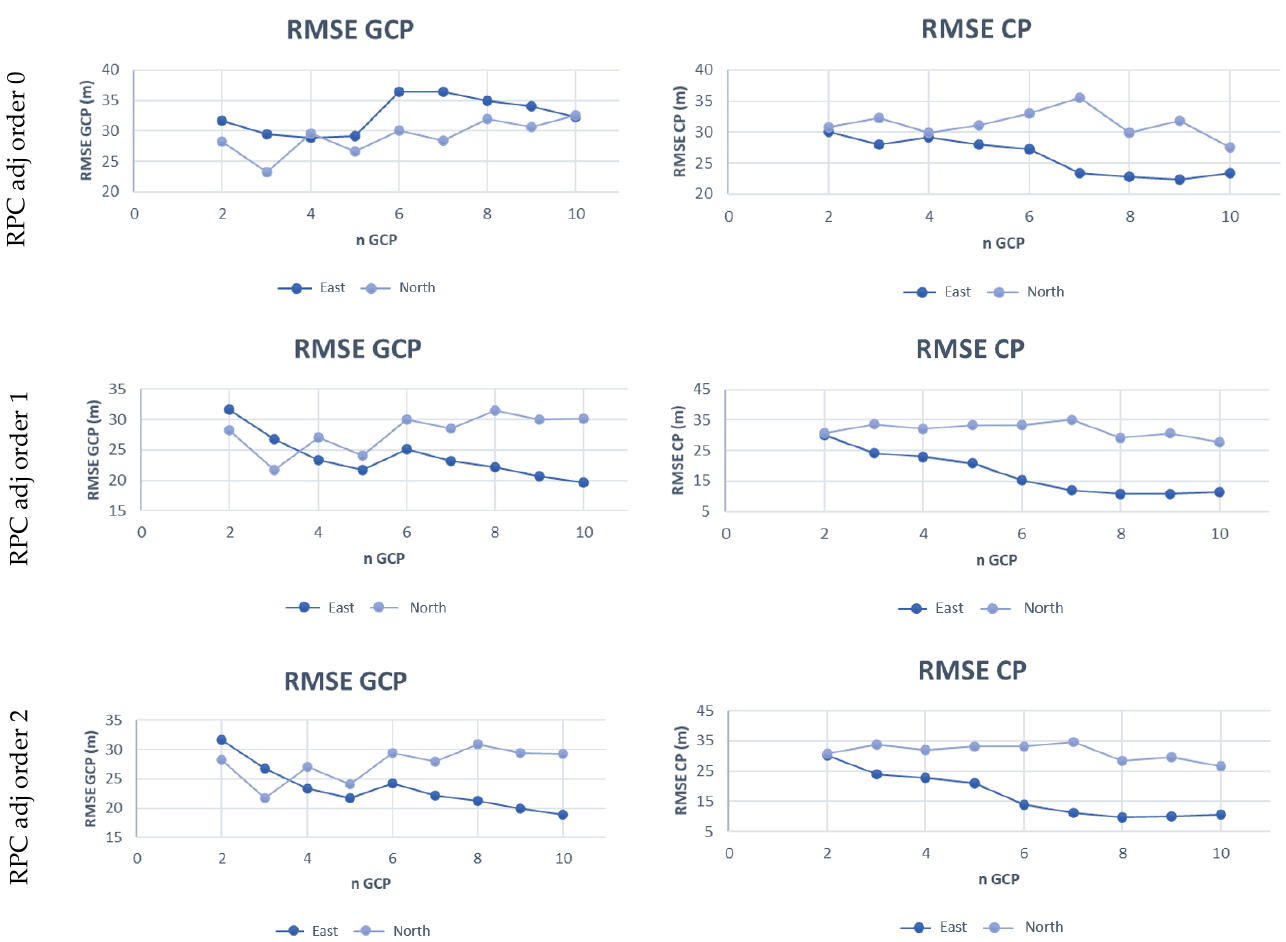
Figure 6. Precision and accuracy trends for Rome image.